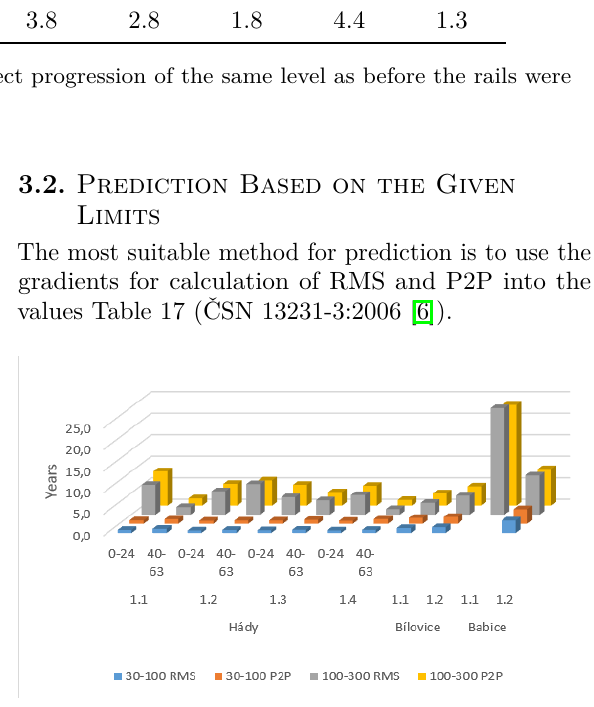
Figure 7. Timeframe needed for the defect progres- sion according to Table 17 (ČSN 13231-3:2006 [6]). The same applies to the standard SŽDC S2/4 [8] for the level 0.1 mm.